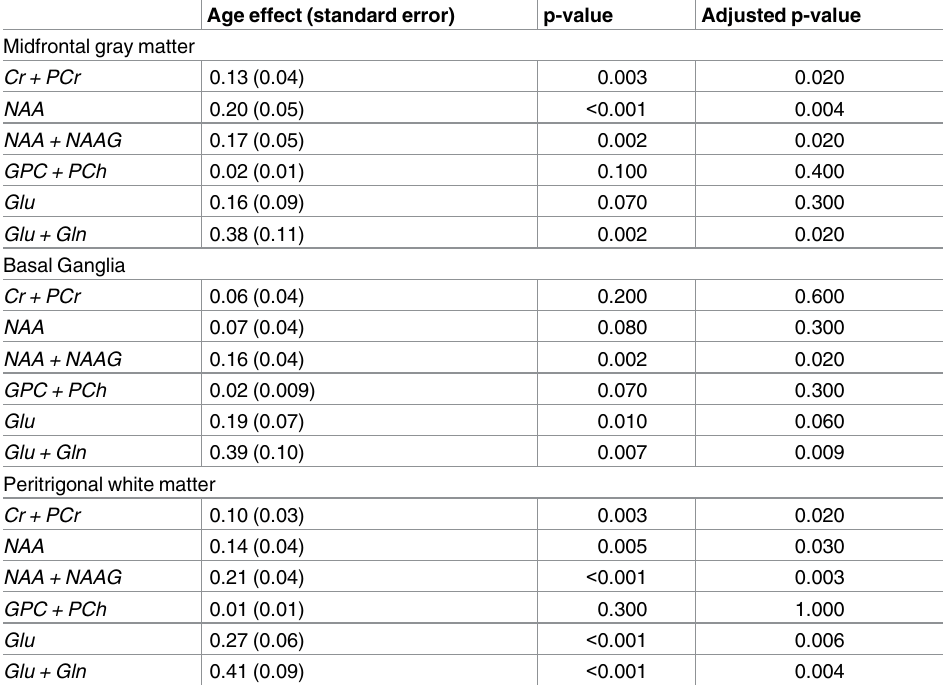
Table 3. Summary of linear mixed effects (LME) model of metabolite levels with